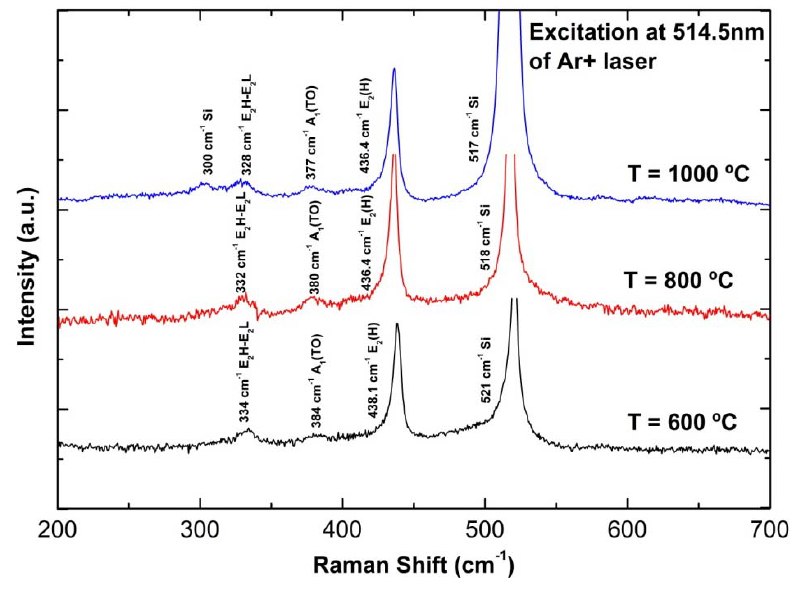
Figure 6. Raman scattering spectra of ZnO nanorods grown on PS substrates at different growth